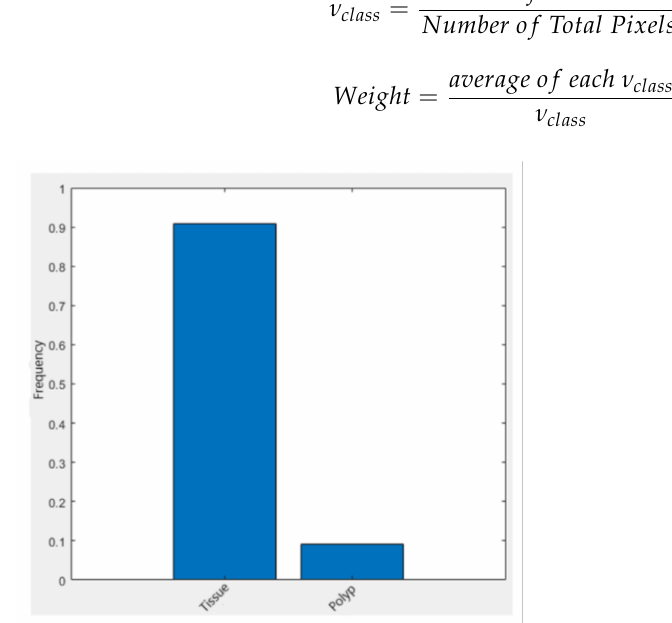
Figure 5. Pixels frequency corresponding to each